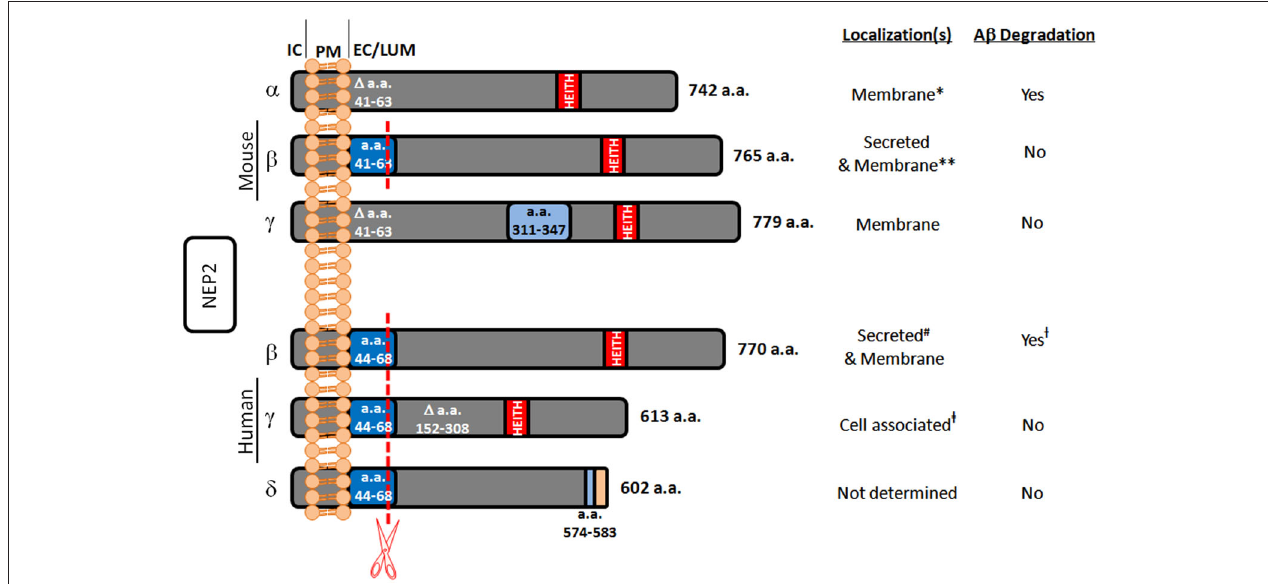
critical zinc-binding motif (HEITH). IC, intracellular; PM, plasma membrane; EC/LUM, extracellular or luminal; * associated with the membrane fraction and located inside the cell (Ikeda et al., 1999); however, in vitro expression did show the ability to degrade extracellular A β (Hafez et al., 2011); ** primarily secreted (Ghaddar et al., 2000) but also found in the membrane fraction (Ikeda et al., 1999; Raharjo et al., 2001; Shirotani et al., 2001). # associated with the membrane fraction and secreted (Whyteside and Turner, 2008); however, also shown to be expressed on the cell surface and to degrade extracellular A β (Huang et al., 2008); † A β -degrading activity found only at the extracellular surface (Huang et al., 2008); ‡ found in the total cell lysate (subcellular compartment localization not done) (Huang et al.,